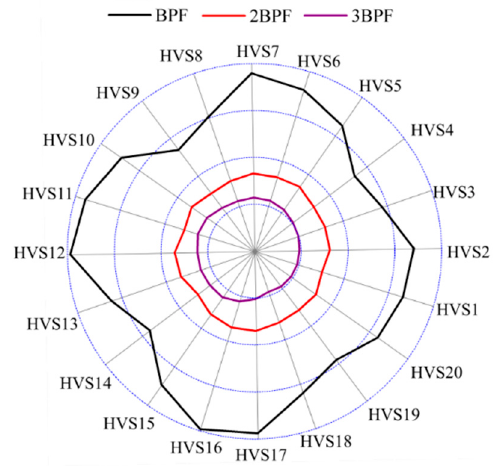
Figure 9. Pressure fluctuation component of BPF, 2BPF and 3BPF in the vaneless space (P2).